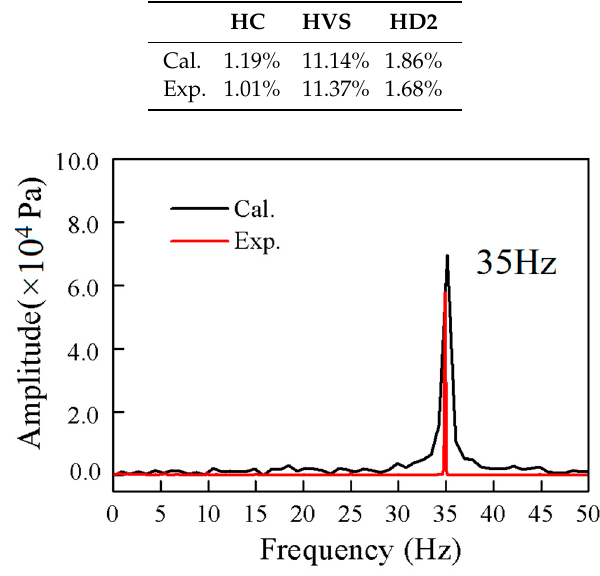
Figure 7. Accuracy validation of spectrum analysis of pressure fluctuations.